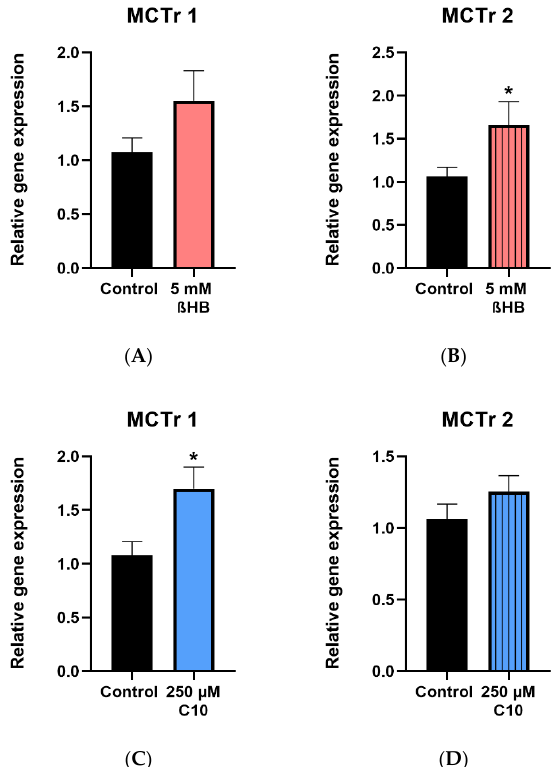
Figure 6. Gene expression of monocarboxylate transporters (MCTr 1 and MCTr 2) in 5 mM ßHB (Figure 6 A and B ) or 250 µM C10-treated HT22 cells (Figure 6 C and D ), relative to control (untreated) or 250 µ M C10-treated HT22 cells ( C , D ), relative to control (untreated) probes. Data are represented as probes. Data are represented as mean + SD; * p < 0.05 ( n = 3). mean + SD; * p < 0.05 ( n =